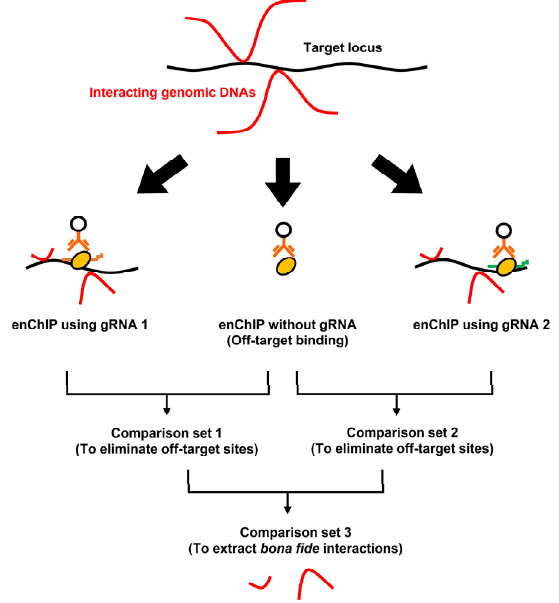
Figure 1. An example of using enChIP-Seq to identify interacting genomic regions. enChIP-Seq was performed in the presence of different gRNAs or in the absence of a gRNA (a negative control). Peaks detected by enChIP without gRNA were subtracted from those for enChIP-Seq with gRNAs to eliminate off-target sites (Comparison sets 1 and 2). Subsequently, the resultant data could be compared to extract bona fide interactions.